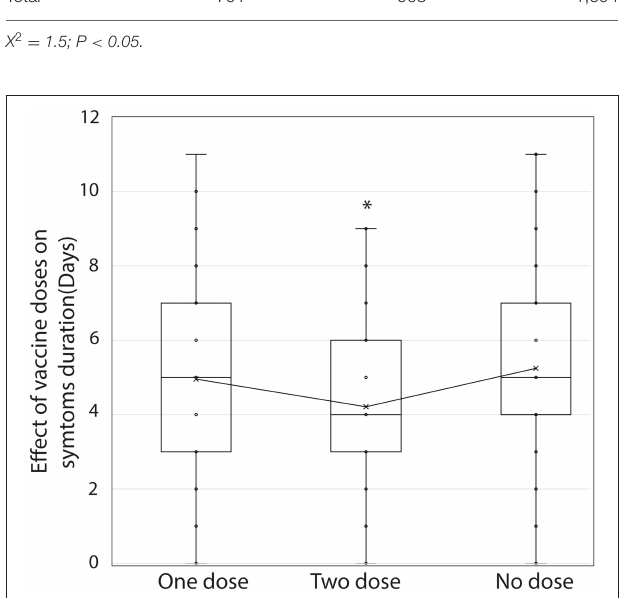
FIGURE 3 | Effect of vaccination on the duration of COVID-19 symptoms. The period in days of duration of symptoms in patients with incomplete vaccination (one dose), complete vaccination (two doses), and without vaccination (no dose) during the second wave is shown. * p < 0.05. Analysis performed with a chi-square